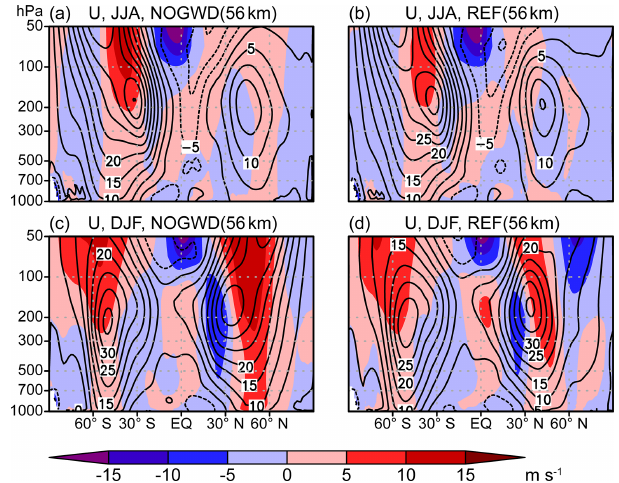
Figure 14. Zonal mean zonal wind (contours) and its bias from JRA-55 reanalysis (shadings) for June–August 2004 (a, b) and De- cember 2004–February 2005 as simulated by NICAM16-9S with- out ( a , c ; NOGWD run) and with ( b , d ; the REF run) the gravity wave drag scheme.